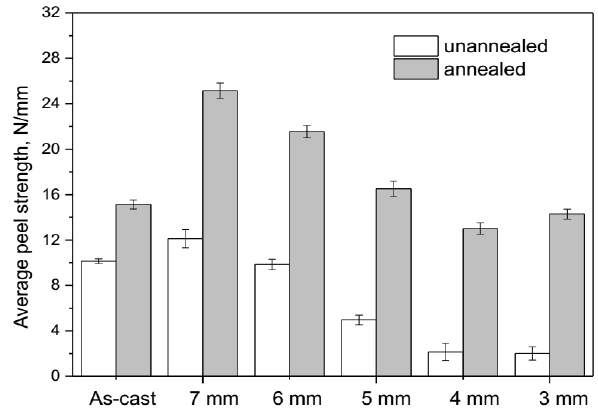
Figure 7. The average peel strength of the Cu/Al clad sheets under different conditions: H-TRC, multi-pass rolling, and annealing.